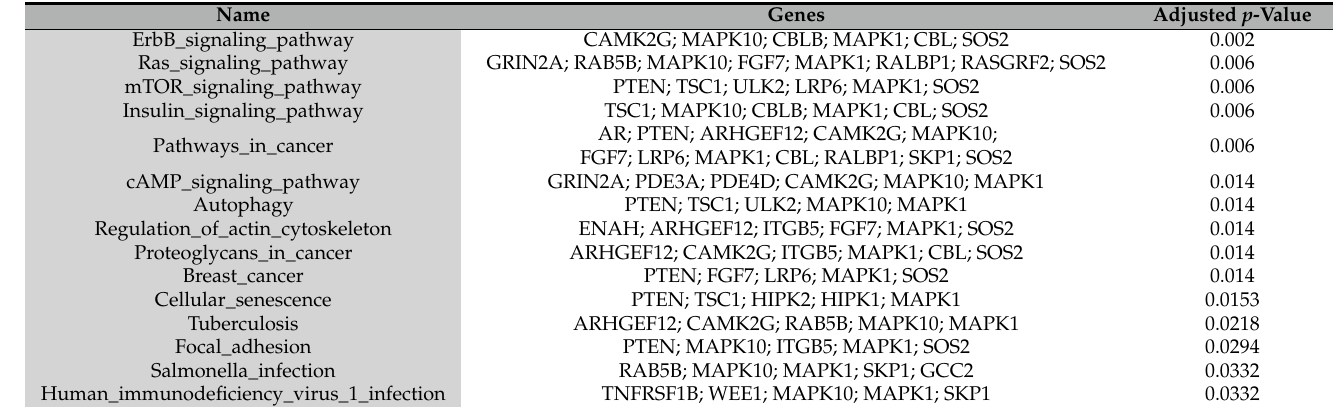
Table 2. Associated biological pathways with miRNA targets: KEGG pathway.